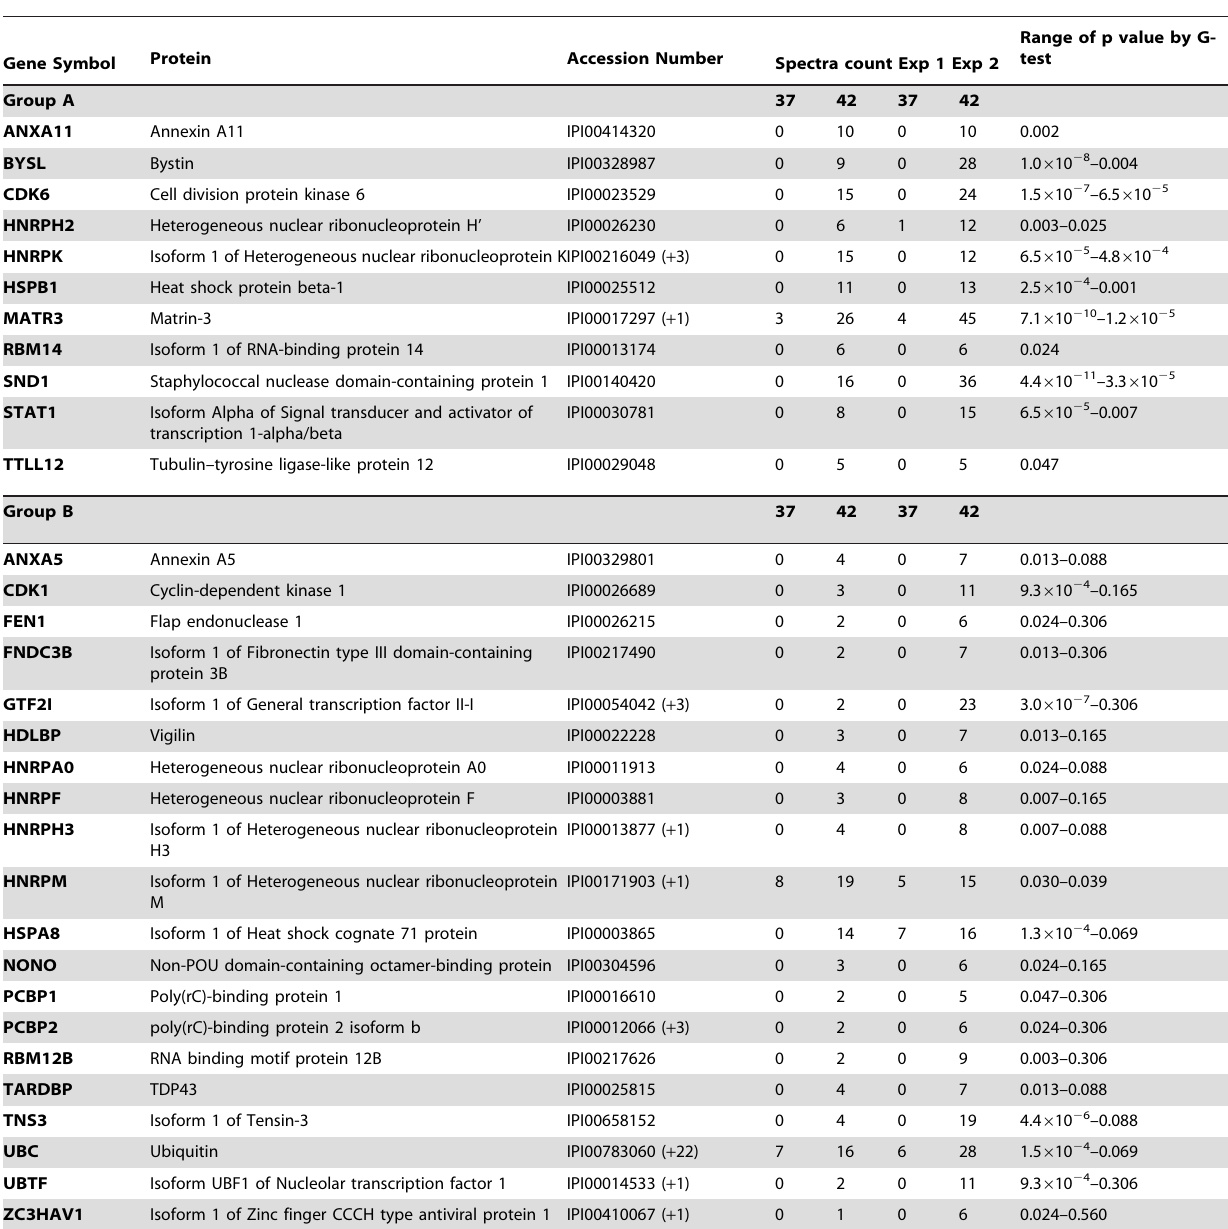
Table 2. Insoluble proteins in CCF-STTG1 cells identified after 42 u C heat-shock treatment.